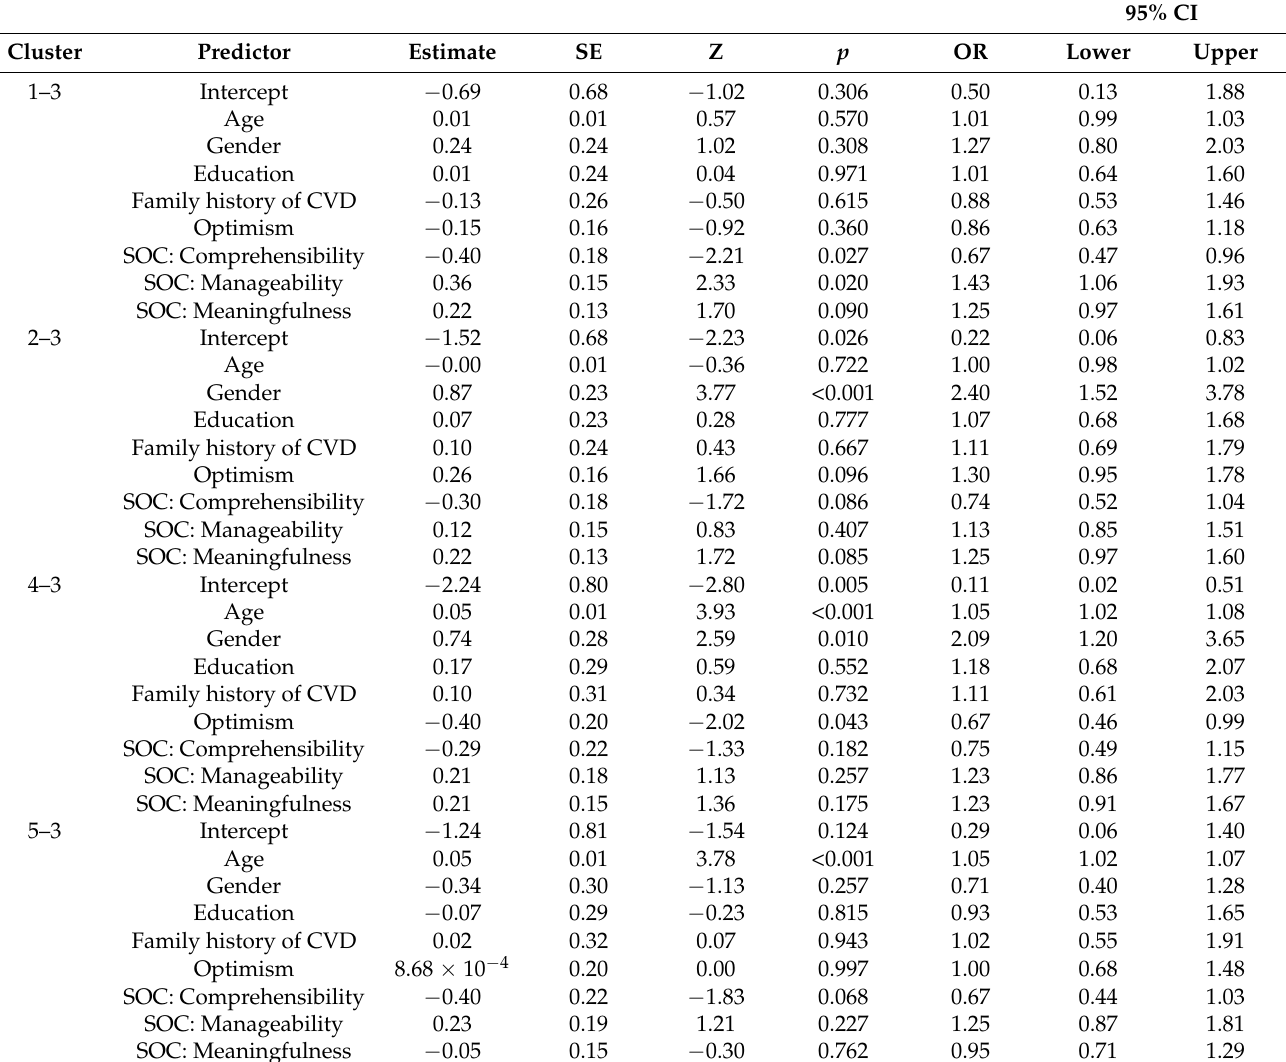
Table 4, five independent variables made a unique, statistically significant contribution to the model (age, gender, SOC Comprehensibility, SOC Manageability, and optimism). Cluster 3 was chosen as the reference level for comparisons between clusters, considering that respondents who fit this profile exhibited “average behavior” across all five lifestyles (see Figure 2). Table 4. Multinomial logistic regression analyzing influences of the demographic and psychological variables on lifestyle profile.